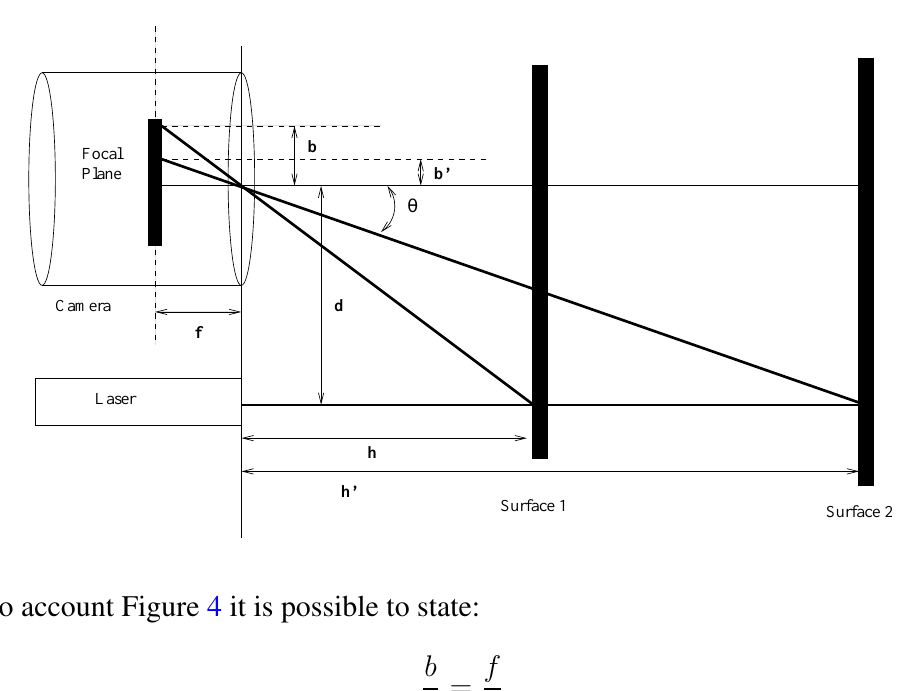
Figure 4. Simplified triangulation for one